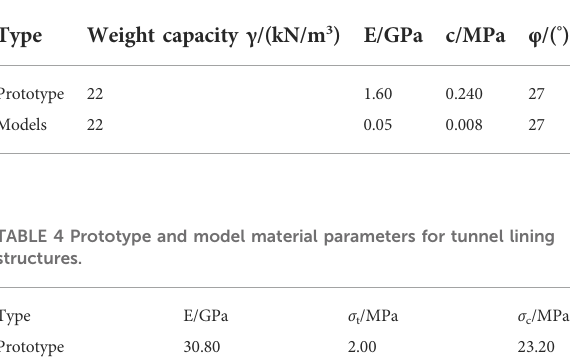
TABLE 3 Prototype and model material parameters for the surrounding rock.